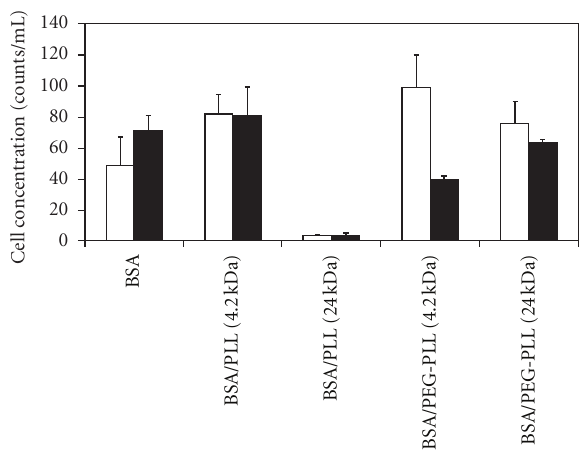
Figure 3: Cell concentrations after exposure to blank NPs ( (cid:2) ) and FAM-siRNA-containing NPs ( (cid:3) ). The value in parentheses represents the molecular weight of the PLL in kDa. The NPs coated in PEG-PLL (4kDa) and containing FAM-siRNA showed the greatest cell concentrations. Data represent average ± 1 SD, n > 5.